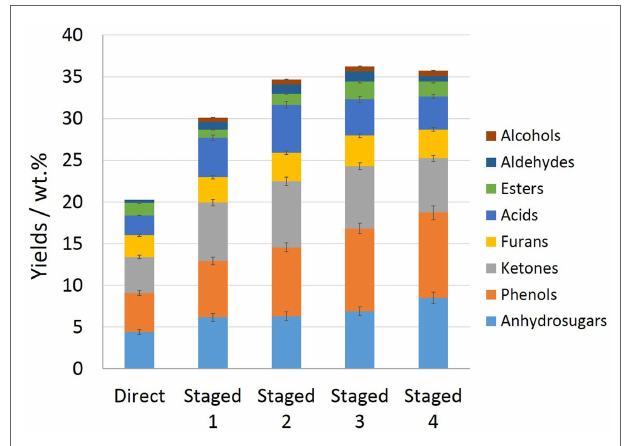
FigUre 6 | chemical composition of pine bio-oil from direct and staged pyrolysis (staged 1, 2, 3, and 4 were representative of pretreatment temperature of 260, 280, 300, and 320° c, respectively, before pyrolysis in fluidized-bed reactor at 520°c) .